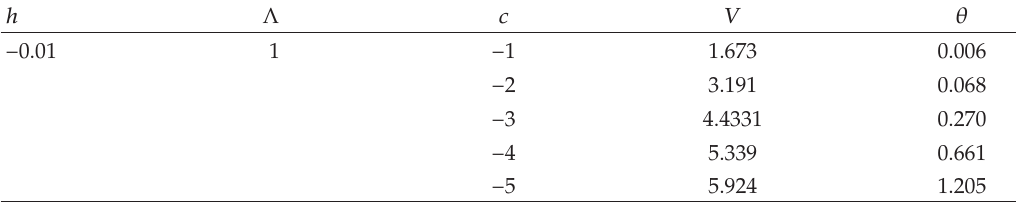
Table 1: Illustrating the variation of the velocity and temperature with c . h Λ c V θ − 0.01